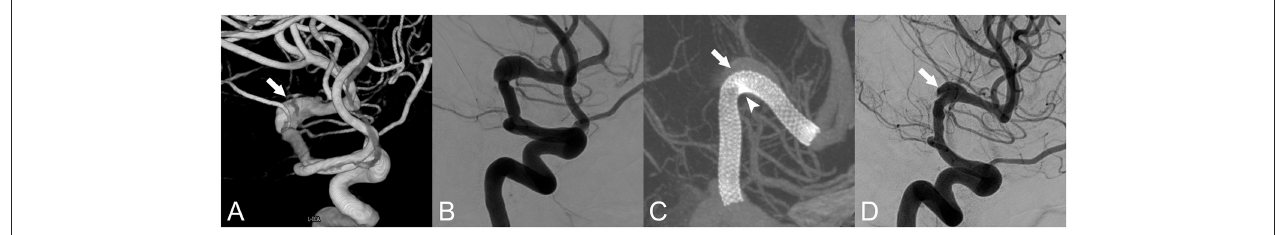
FIGURE 1 | Fusiform aneurysm of the left middle cerebral artery. (A) Three-dimensional reconstruction of the fusiform aneurysm (white arrow). (B) Anteroposterior projection by digital subtraction angiography (DSA). (C) Vaso CT indicated that the metal coverage of the small curve (arrow head) was higher than that of the large curve (white arrow). (D) A 9-month follow-up angiography showed that the aneurysm remained residual (white arrow), and the intima had formed between the stent and the aneurysm.